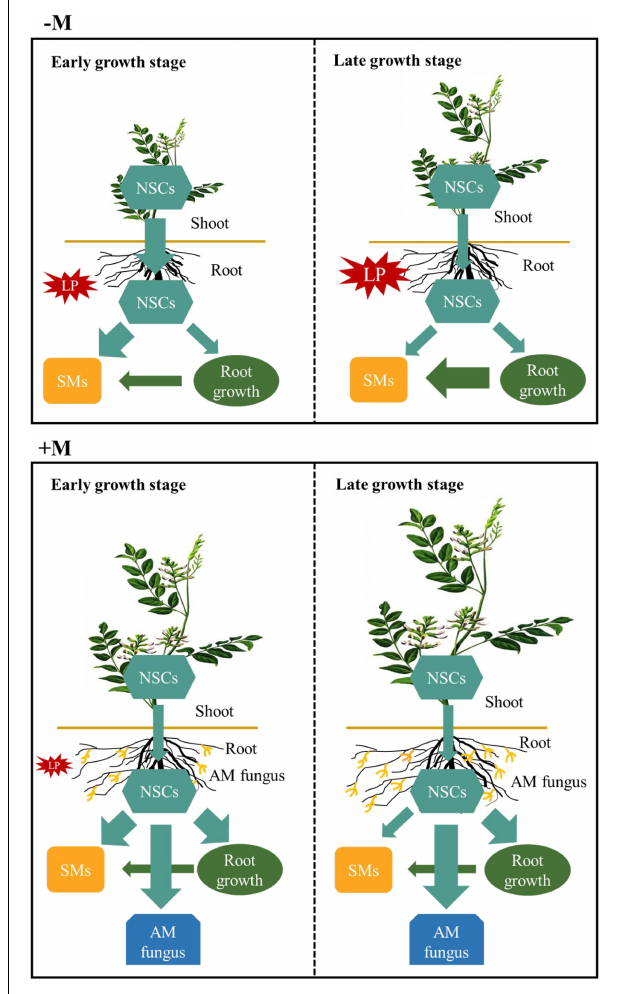
FIGURE 8 | A schematic summary of carbon (C) allocation and partitioning patterns in Glycyrrhiza uralensis plants. For non-mycorrhizal (–M) plants, transport of non-structural carbohydrates (NSCs; light blue arrows and boxes) from shoots to roots was increased (broad arrows), along with more root NSC partitioning to secondary metabolites (SMs; yellow boxes) under phosphorus (P) limitation (red explosion) in the early growth stage; in the late growth stage, the –M plants suffered more severe P limitation (enhanced red explosion), which resulted in more root growth C (dark green arrows and boxes) partitioning to SMs without any change shoot NSC allocation to roots. For the mycorrhizal (+M) plants, transport of NSCs from aboveground to belowground did not change under P limitation for both plant growth stages, but more root C was partitioned to SMs, root growth, and AM fungus (dark blue boxes) at the expense of NSCs in the early growth stage. However, when P deficiency stress was relieved in the late growth stage, the +M plants partitioned more NSCs to root growth and AM fungus instead of